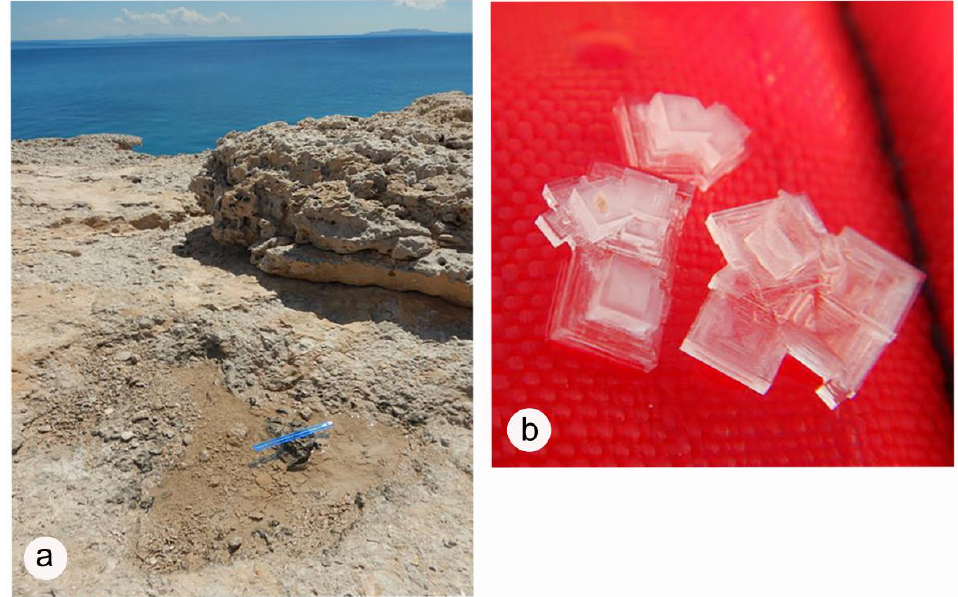
Figure 5. Evidence from a saltwater pool on the coastal terrace at Arroyo Banco: ( a ) Shallow depression on the limestone surface filled with seawater (blue ruler = 30 cm); ( b ) Close-up of individual salt crystals recovered from the brine of another pool exhibiting a characteristic cubic habit (maximum crystal size is 5 mm in diameter).